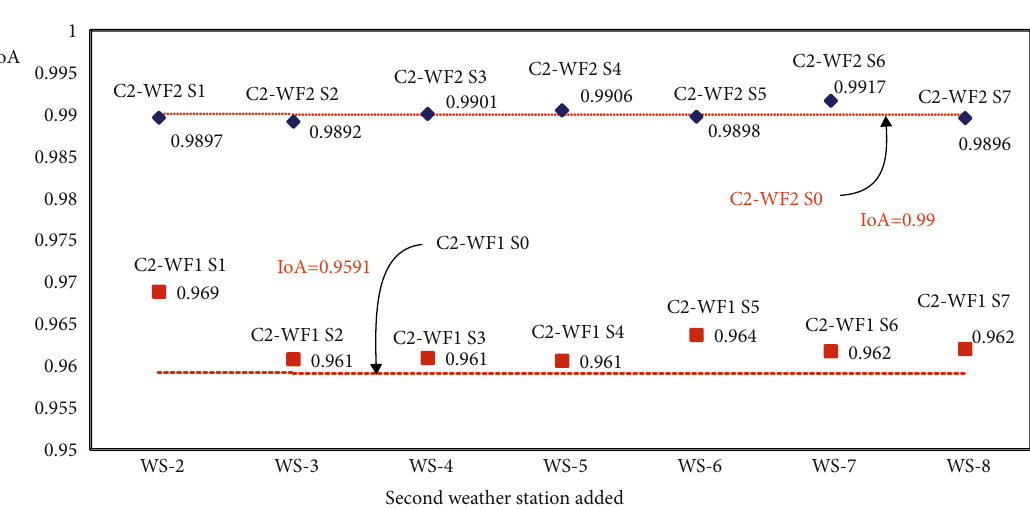
Figure 11: Comparison of the “IoA” results for Case 2 and Case 1 (C2-WF